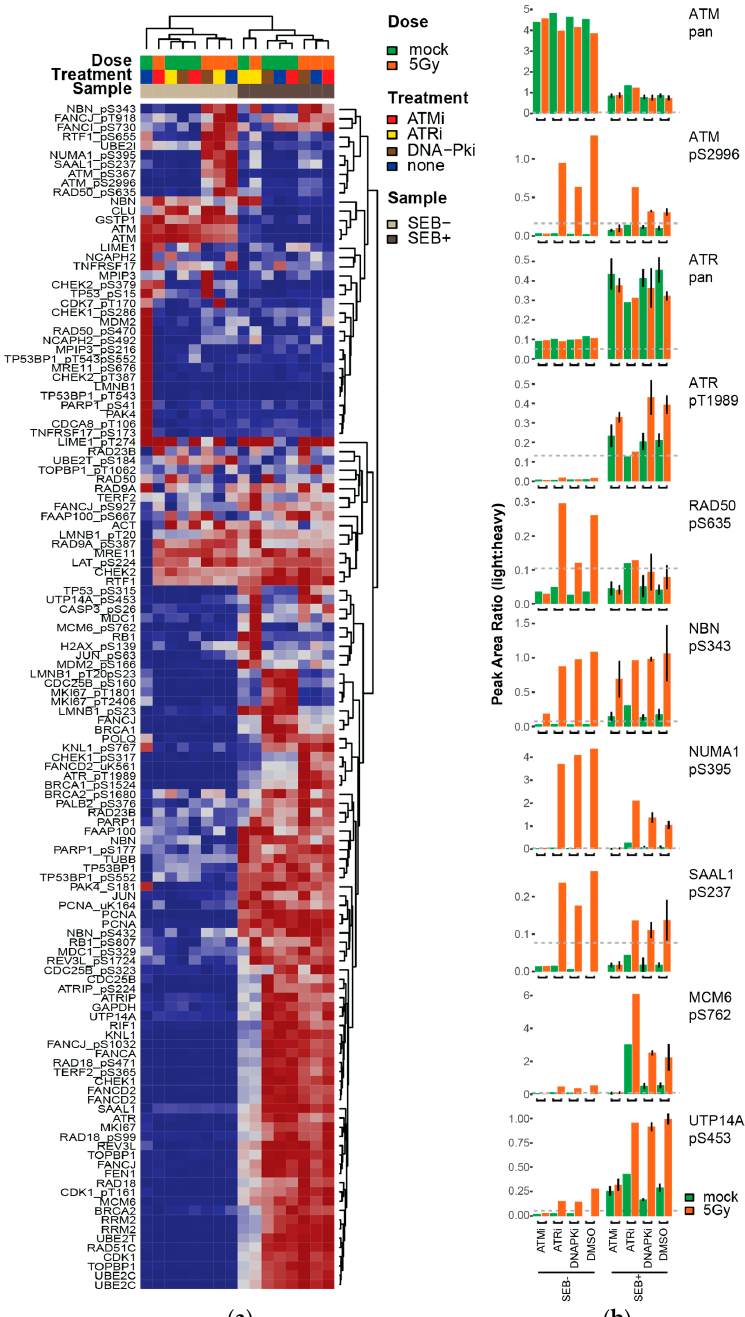
Figure 4. Pharmacodynamic profiling of cell signaling dynamics. ( a ) Heatmap showing unsupervised clustering of analytes and samples for PBMCs exposed to ionizing radiation in the presence of ATM, ATR, or DNA-PK kinase inhibitors. Peak area ratios (light:heavy) were normalized for each peptide analyte. ( b ) Bar plots showing peak area ratios (light:heavy) for selected analytes. For each kinase inhibitor, the pair of mock-treated (green) and irradiated (orange) cells are plotted. Error bars show the standard deviation of triplicate analysis (SEB+, ATMi and DMSO samples) or the range of duplicate analysis (SEB+, DNAPKi samples). To meet the assay sample requirements, two individuals (i.e., biological duplicate reps) were used for DNAPKi samples, and a single individual sample was used (i.e., singlicate analysis) for the ATRi samples. For the unstimulated cells (SEB − ), lysates from two individuals were pooled to obtain sufficient material (i.e., singlicate technical